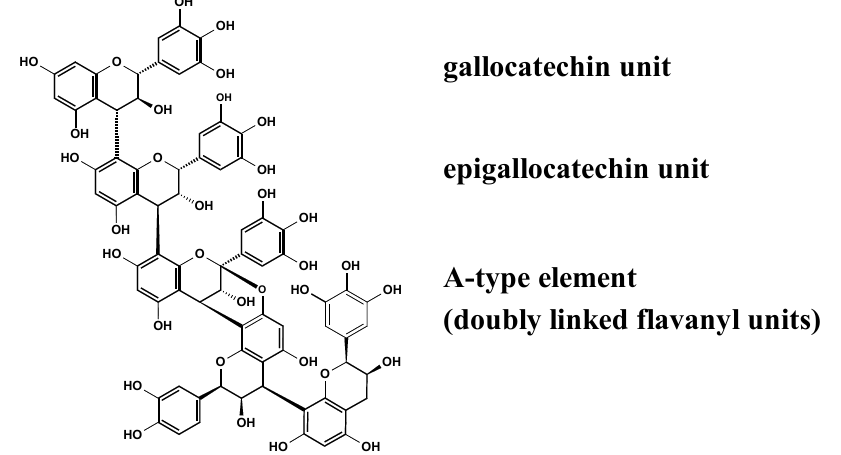
gallocatechin unit epigallocatechin